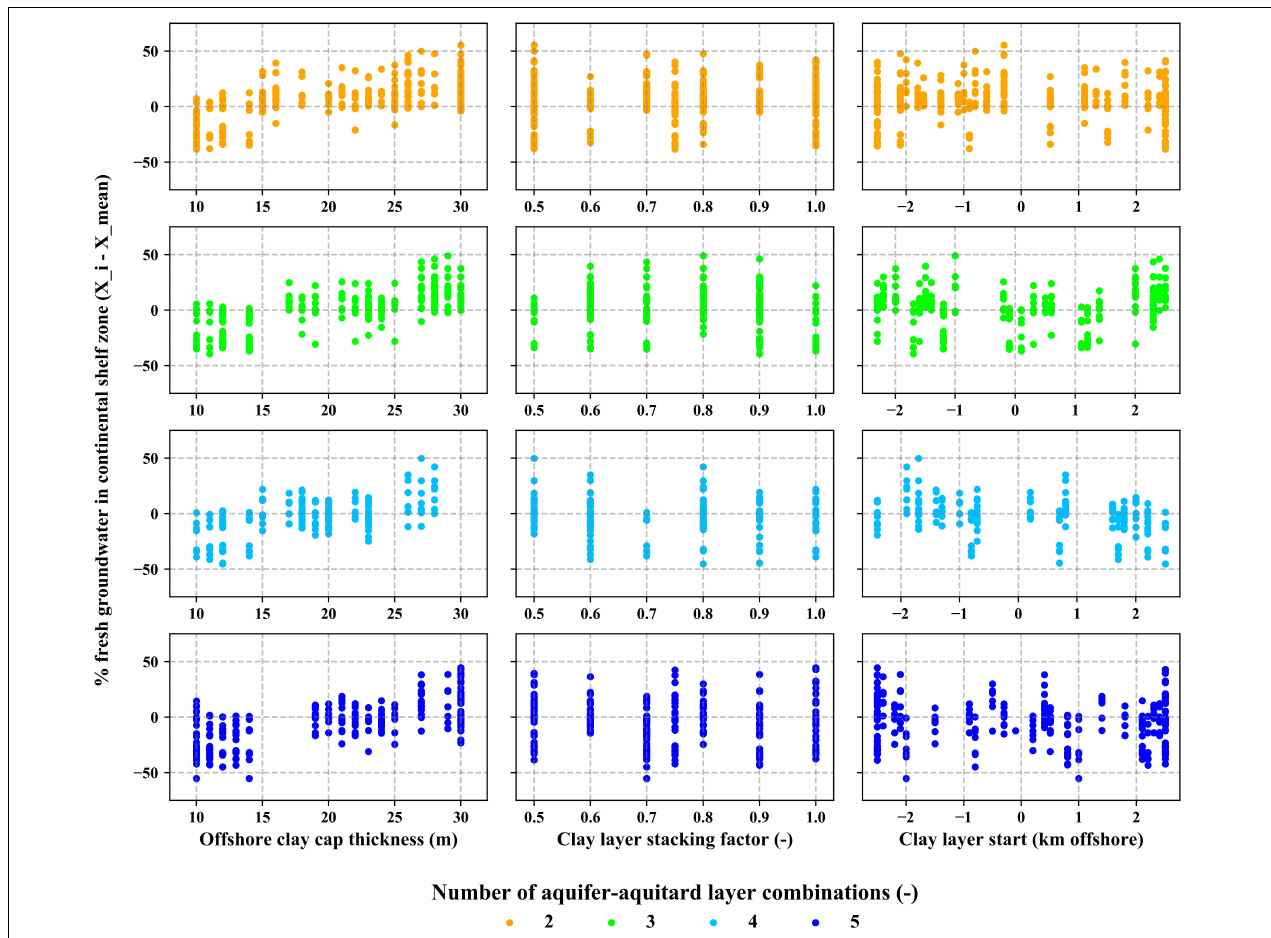
FIGURE 12 | Influence of geological parameters on estimated FGFs (compared to mean value for each selected COSCAT region). Positive values correspond to SEAWAT models that estimate larger FGFs than